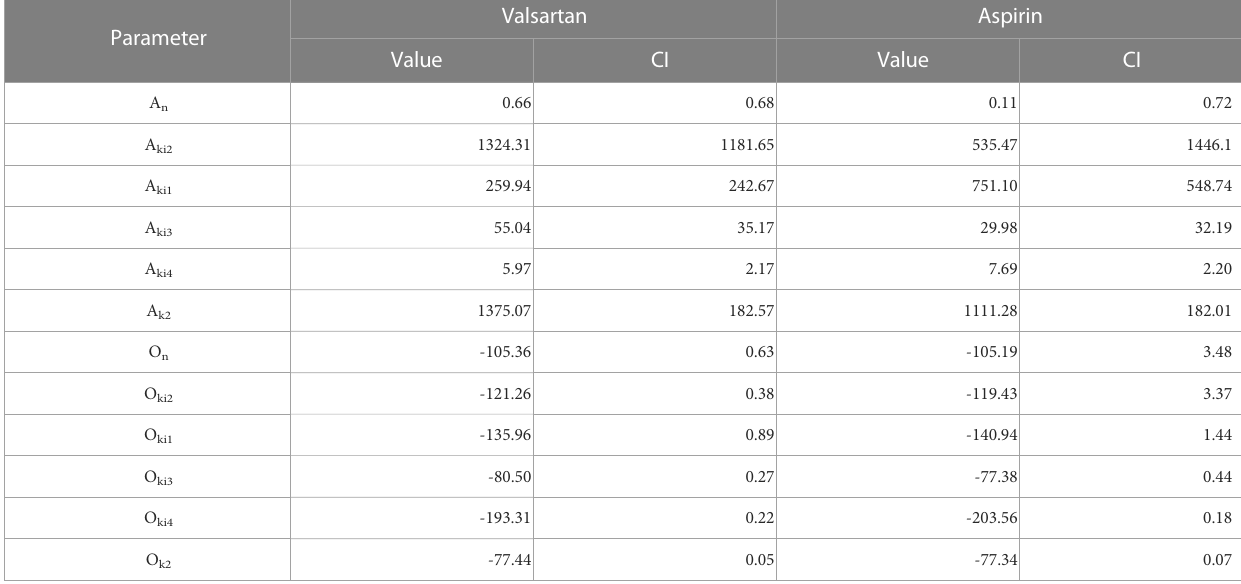
TABLE 3 Estimated parameters of Ta-dependent effect model for valsartan and